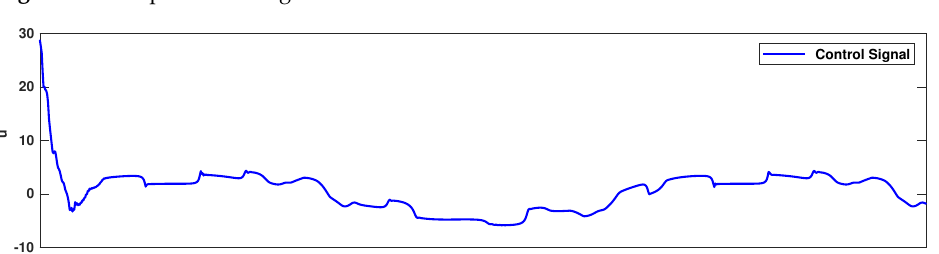
Figure 6. Example 1: tracking error.